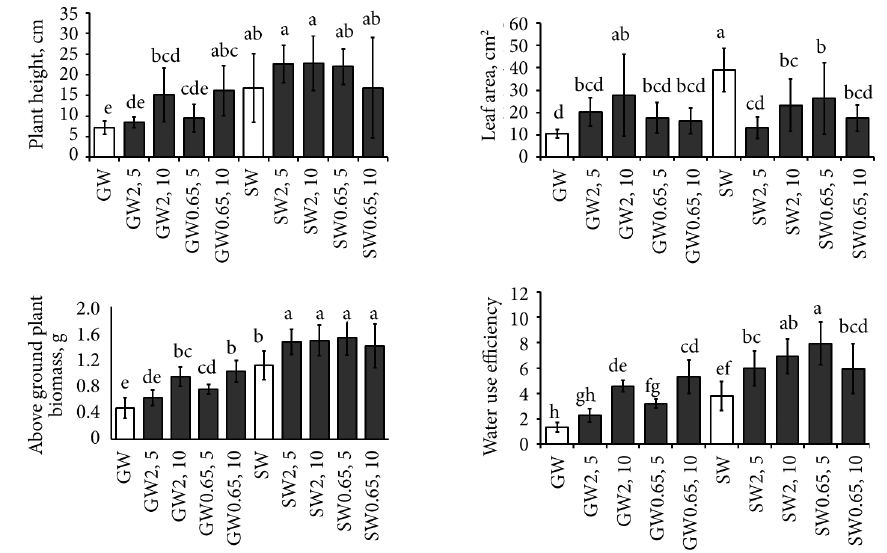
Figure 2. Mean±SD of plant height (cm), leaf area (cm 2 ), above ground biomass dry weight (g) and water use efficiency of spinach in response to various treatments; GW-ground water, SW-wastewater, 2, 5-soil amended with large particle size biochar at 5% amendment rate, 2, 10-soil amended with large particle size biochar at 10% amendment rate, 0.65, 5-soil amended with small particle size biochar at 5% amendment rate, 0.65, 10-soil amended with small particle size biochar at 10% amendment rate. Bars with different letters indicate significant difference at P ≤